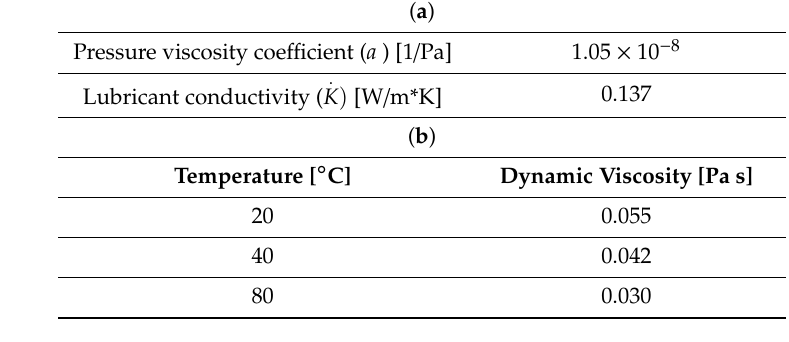
Table 6. ( a ) Lubricant properties and ( b ) dynamic viscosity for different temperatures.